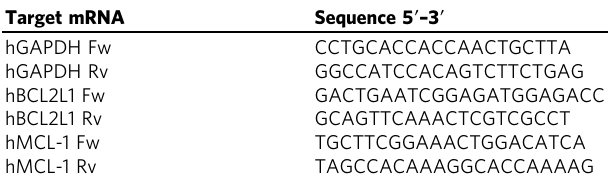
Table 2 Primers used for human gene detection Target mRNA Sequence 5 ′ – 3